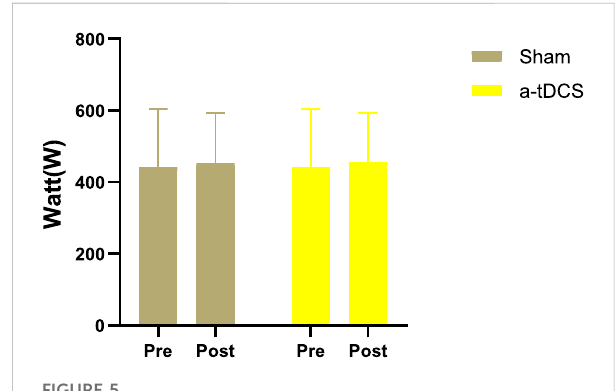
FIGURE 5 Left-arm pull-down explosive force. The white bars represent real stimulation compared to pre-stimulation, and the gray bars represent sham stimulation compared to pre-stimulation. “ Pre ” indicates before stimulation, while “ post ” represents after stimulation.